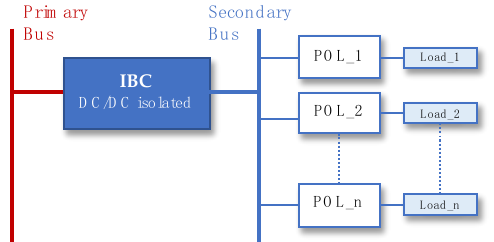
Figure 1. Intermediate bus converter (IBC) converter in a distributed power architecture. POL: point of load.